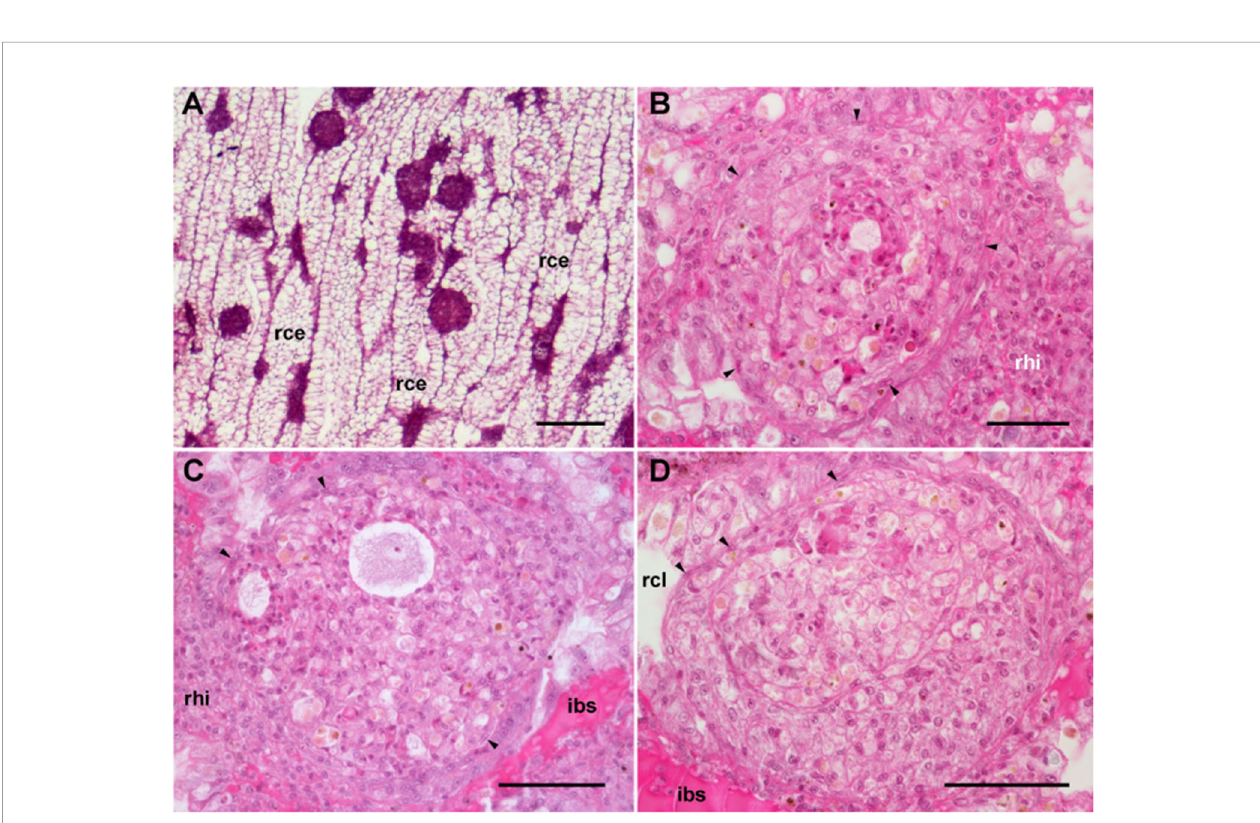
FIGURE 7 | Nodular hemocyte reactions after an immune challenge (hematoxylin-eosin stain). (A) Field view of the dorsal kidney epithelium showing enlarged islets and nodules 96 h after yeast inoculation. (B, C) Detail of hemocyte nodules in another treated snail showing acellular cavities, apoptotic bodies, lipofuscin-like deposits, some granulocytes, and a delimiting band of fl attened cells (black arrowheads). The nodule is pushing against the cavity of a crypt in (B) , while is in contact with a blood sinus in (C) . (D) A nodule showing a core and a cortex; the core appears to be in a more advanced stage of regression; bands of fl attened cells separate the core from the cortex, and the cortex from the surrounding tissues and a blood sinus. Scale bars represent: (A) 200 µm; (B – D) 50 µm. IBS, intercryptal blood sinus; RCE, renal cryptal epithelium; RCL, renal cryptal lumen; RHI, renal hemocyte islet. From (29,